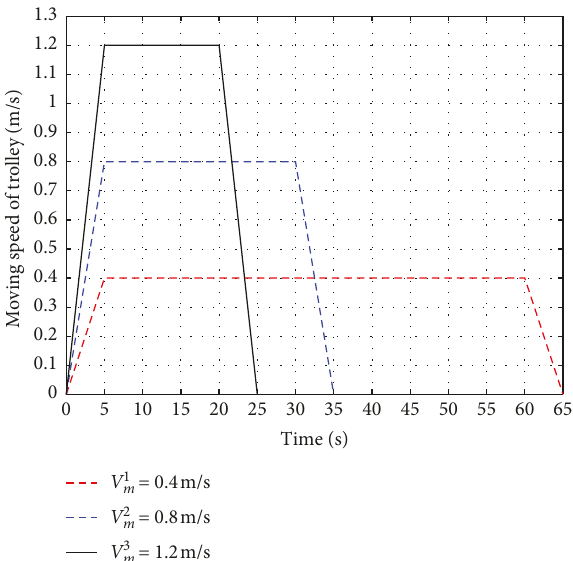
Figure 10: Three speed patterns of the moving trolley.